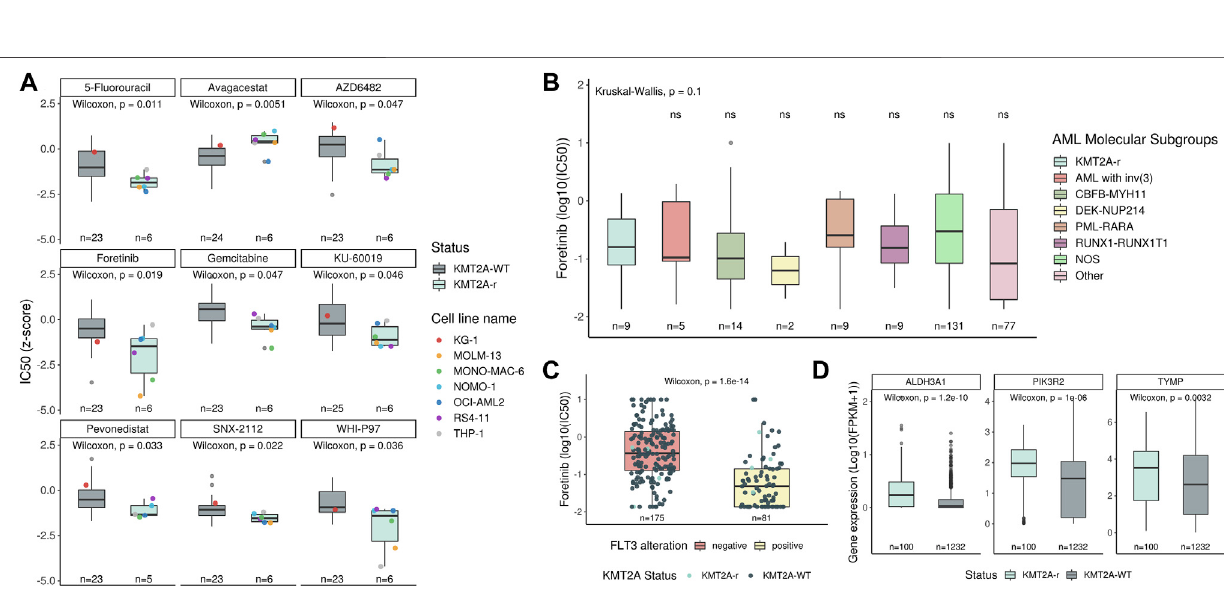
Frontiers in Pharmacology |